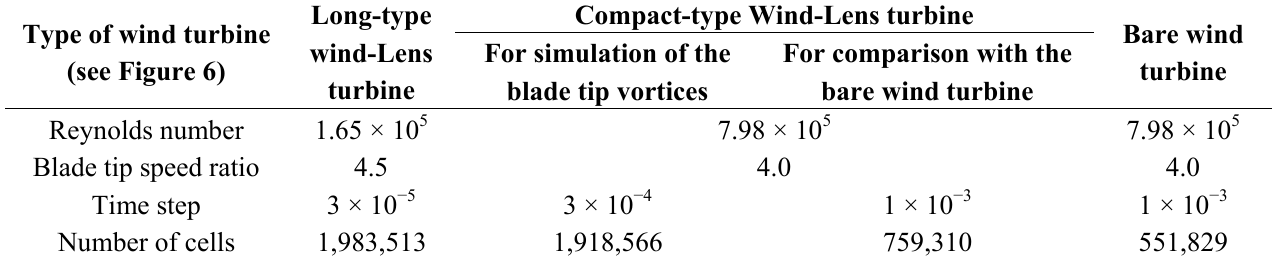
Table 1. Simulation conditions.